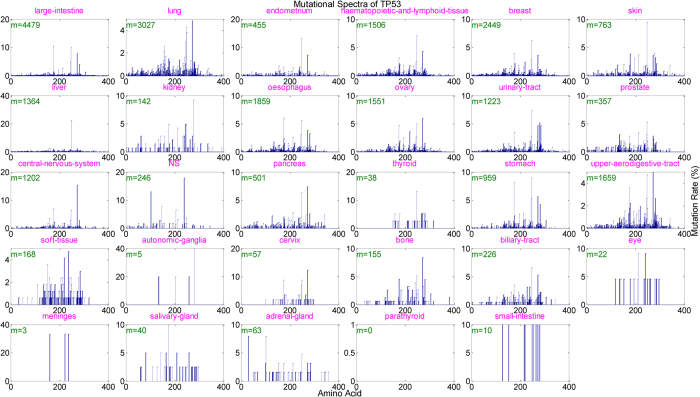
Mutational spectrum of the TP53 gene at the amino acid residue resolution.Horizontal axis represents the amino acid position along the protein sequence; vertical axis indicates the proportion of mutations in that position among all TP53 gene mutations (top left m’s) dected in each cancer. The mutational spectra for other top-ranked genes (KRAS, PIK3CA, PTEN, APC, TTN, and MUC16) are provided in supplementary Figures S28-S33, respectively.